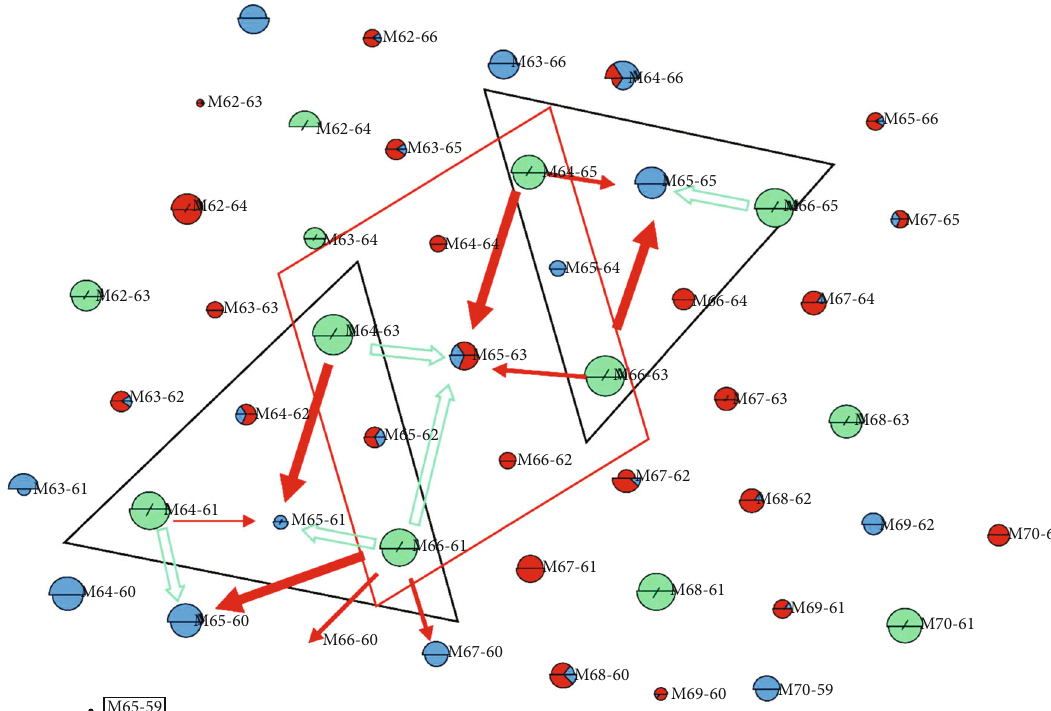
Figure 7: Analysis of channeling direction and channeling ratio of typical well groups (red indicates the direction of channeling, the width of the red arrow re fl ects the proportion of channeling fl ow, and the green arrow indicates that there is no channeling.)